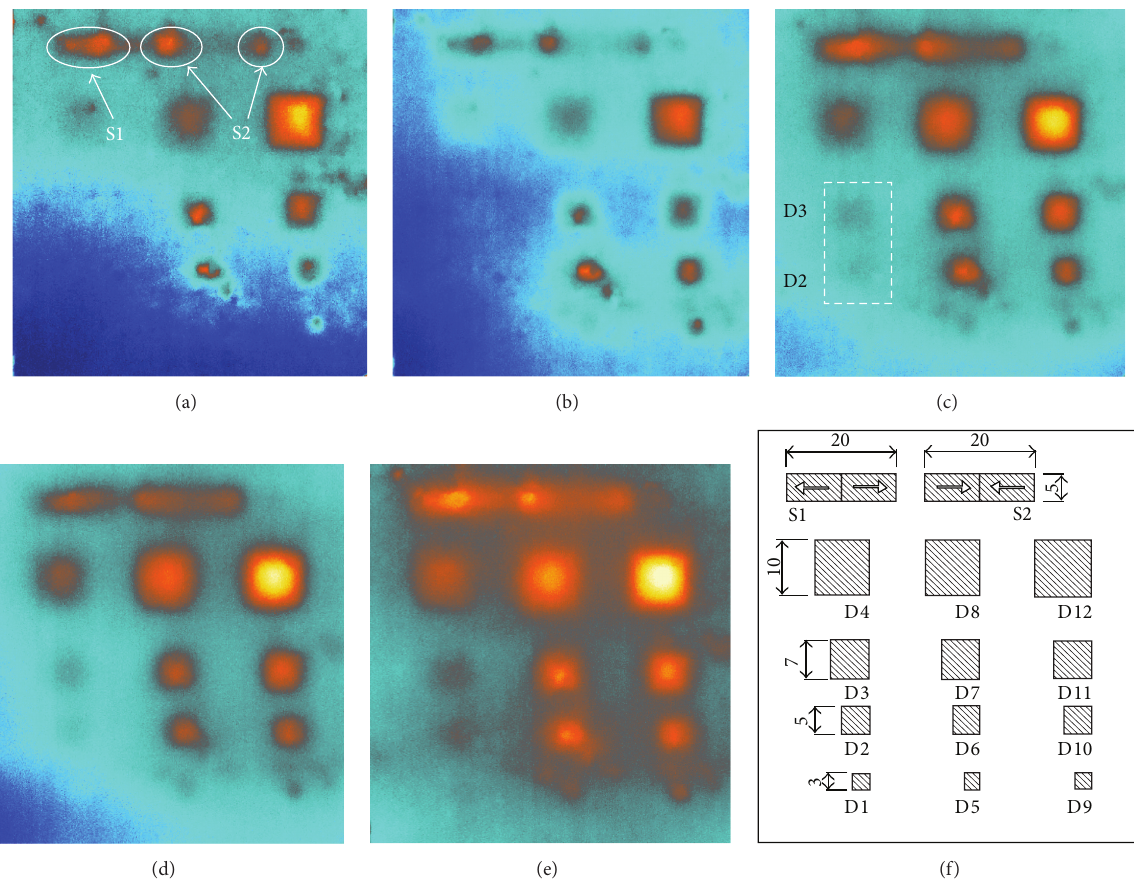
Figure 6: IR thermal images of the five heating cycles: (a) 5, (b) 10, (c) 15, (d) 20, and (e) 25